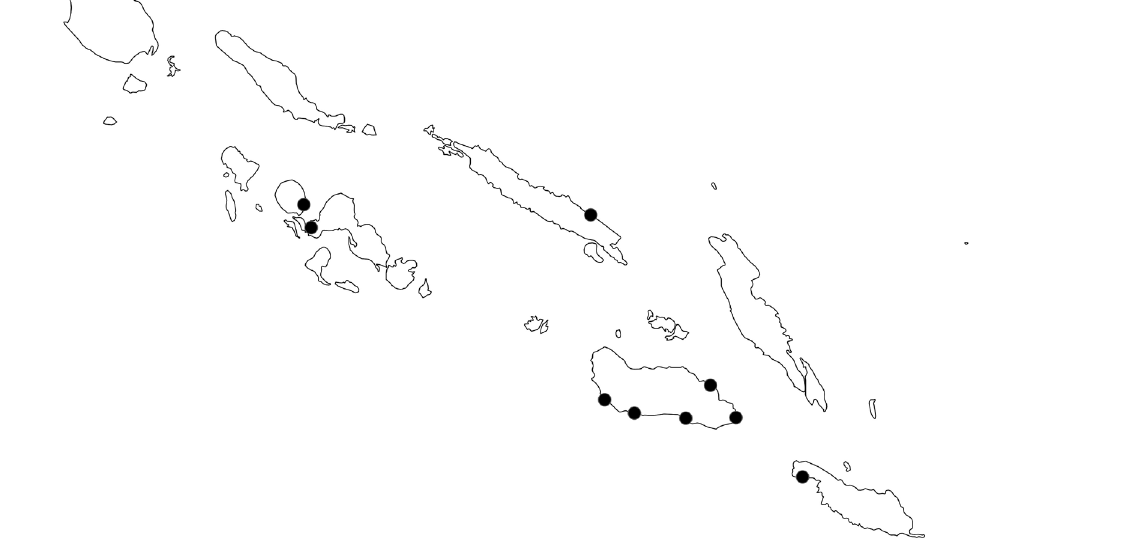
Fig. 6. Map of the Solomon Archipelago showing the collecting localities of Huberantha asymmetrica I.M.Turner & Utteridge sp.